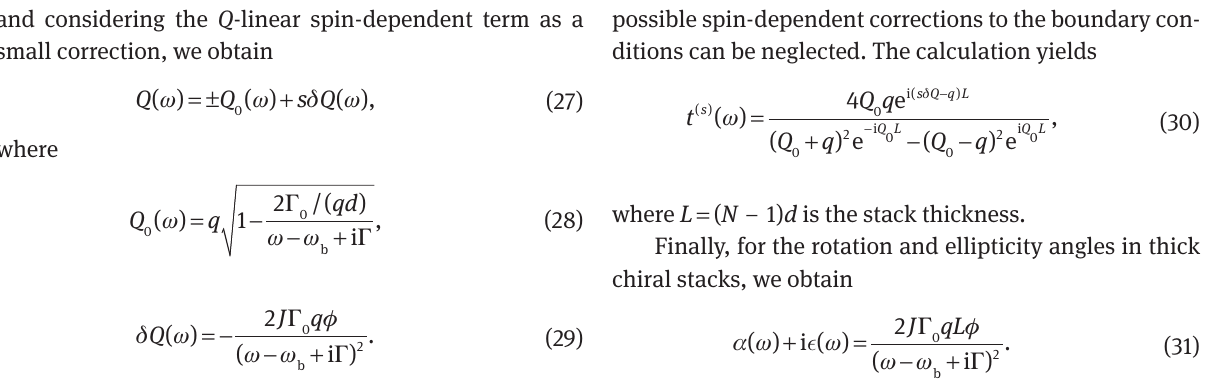
Figure 5 sketches the dispersions of exciton-polari- tons with the spin projections s = ± 1 along the wave vector (solid red and blue curves, respectively) given by Eq. (26)